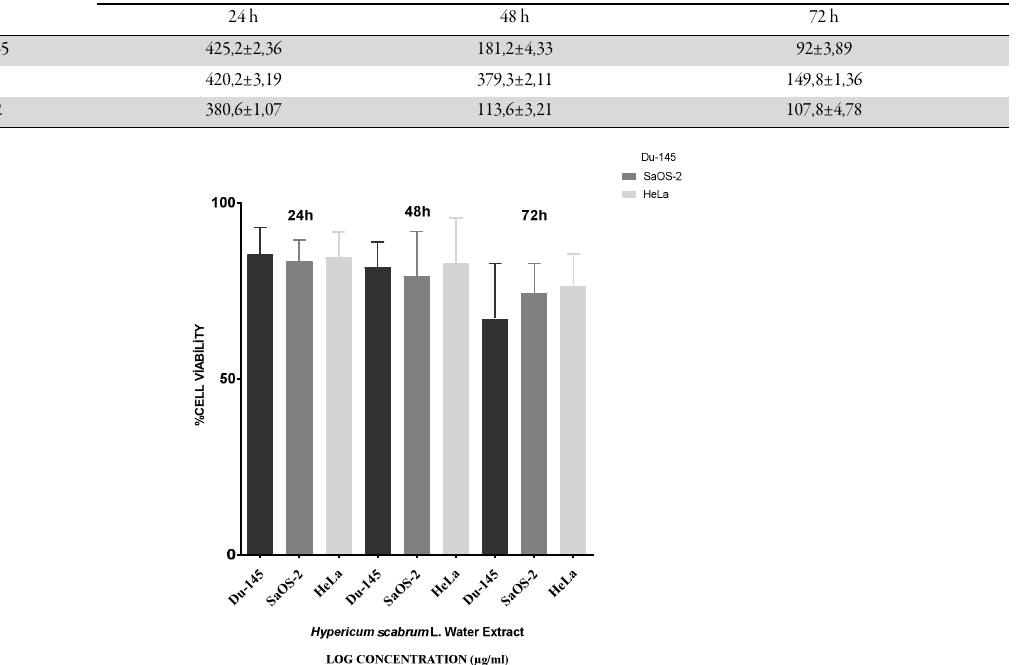
Table 2. Comparison of IC 50 values between Hypericum scabrum L . water extract on different cells after 24 h, 48 h and 72 h of incubation Cells